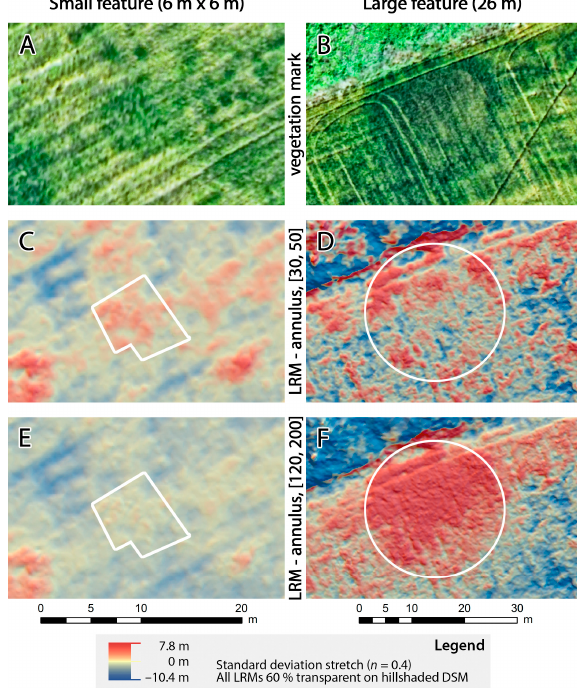
Figure 3. ( A – F ) The influence of kernel size on the visibility of features. The first column depicts a small feature of approximately 36 m 2 , whereas the second column depicts a feature of circa 531 m 2 . It is clear from insets C to F that the smaller feature is only displayed by the smaller annulus kernel size, while the opposite holds for bigger features.